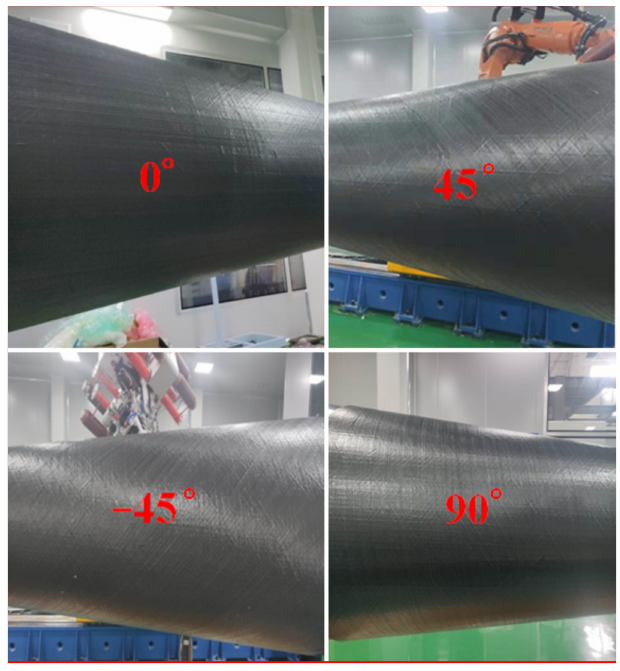
Figure 16. The placement experiment results on the conical shell surface.